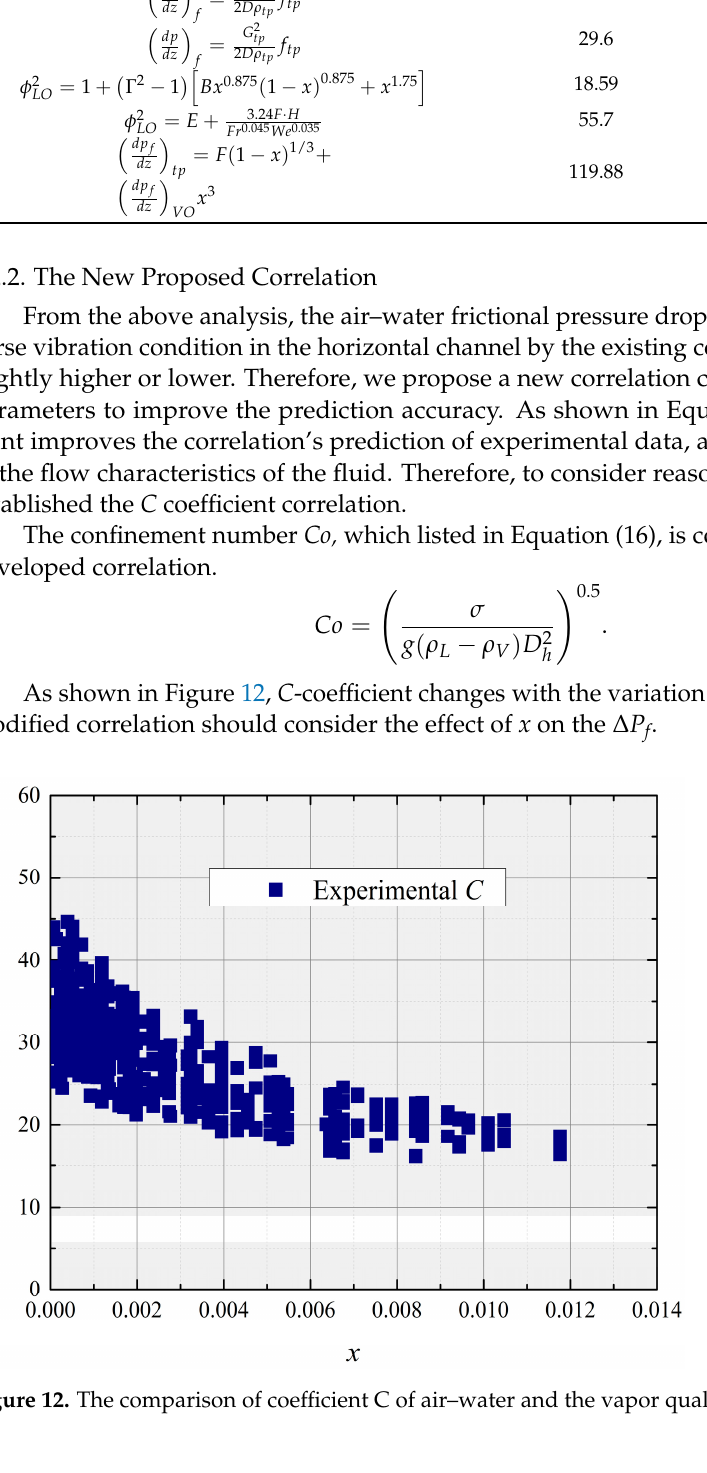
the liquid-phase multiplier with Equations (11) and (13). The fluid properties at each op- erating point were obtained by REFPROP 9 software. Therefore, the X , calculated by Equation (11), was obtained. Thus, we obtained the experimental value of C based on Equation (11). We calculated the values of vapor quality x and Co using Equations (5) and (16) at each operating point. Therefore, based on Equation (17), the coefficients of a 1 , a 2 , a 3 , a 4 and a 5 were obtained; the values are a 1 = − 0.08135, a 2 = 0.96301, a 3 = 0.54807, a 4 = − 79.90416, a 5 = 0.83409. Figure 13 shows the values of the Δ P f calculated by newly developed correlation. Table 4 lists the experimental Δ P f deviation calculated by the developed model. The newly developed model is superior to the Dukler correlation in predicting experimental results under lateral vibration. For the newly developed correlation, the MAD and MRD are 8.2 and 1.4%. Table 4. Comparison of the results of the newly modified correlation and Dukler correlation. Correlations